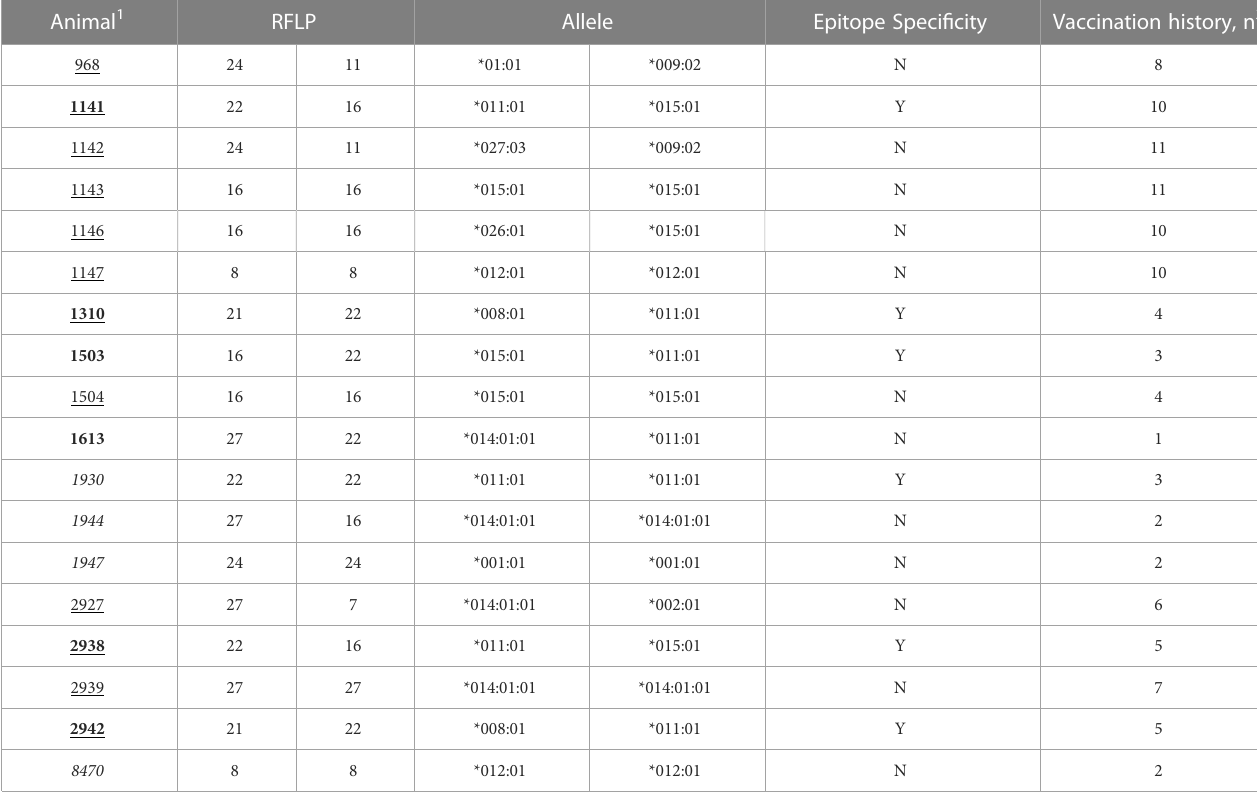
TABLE 3 BoLA-DRB3 alleles of dairy cows screened for responsiveness to BRSV F protein peptides. Animal 1 RFLP